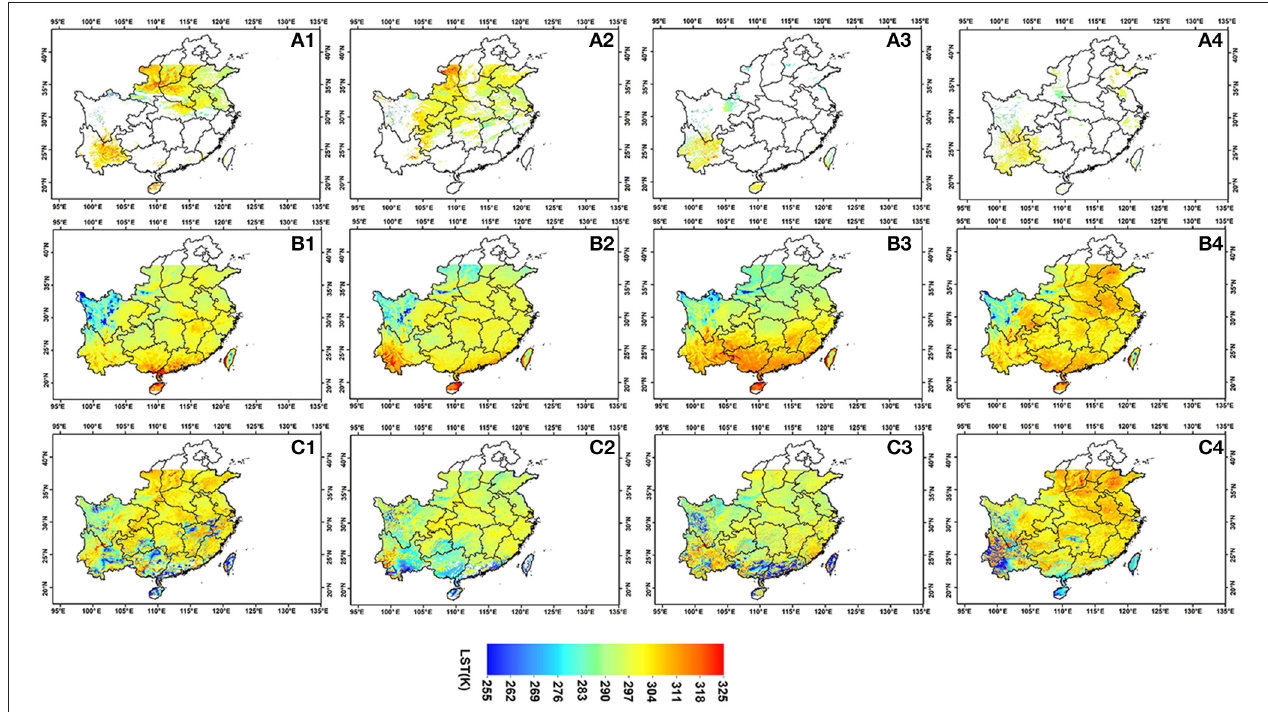
FIGURE 5 | Spatial comparisons of MODIS LST, CLDAS LOT and reconstructed LST (A1–A4) are MODIS LST in April 7, April 14, April 21, and April 28 in 2018, (B1–B4) are CLDAS LST in April 7, April 14, April 21, and April 28 in 2018, (C1–C4) are reconstructed LST in April 7, April 14, April 21, and April 28 in 2018.